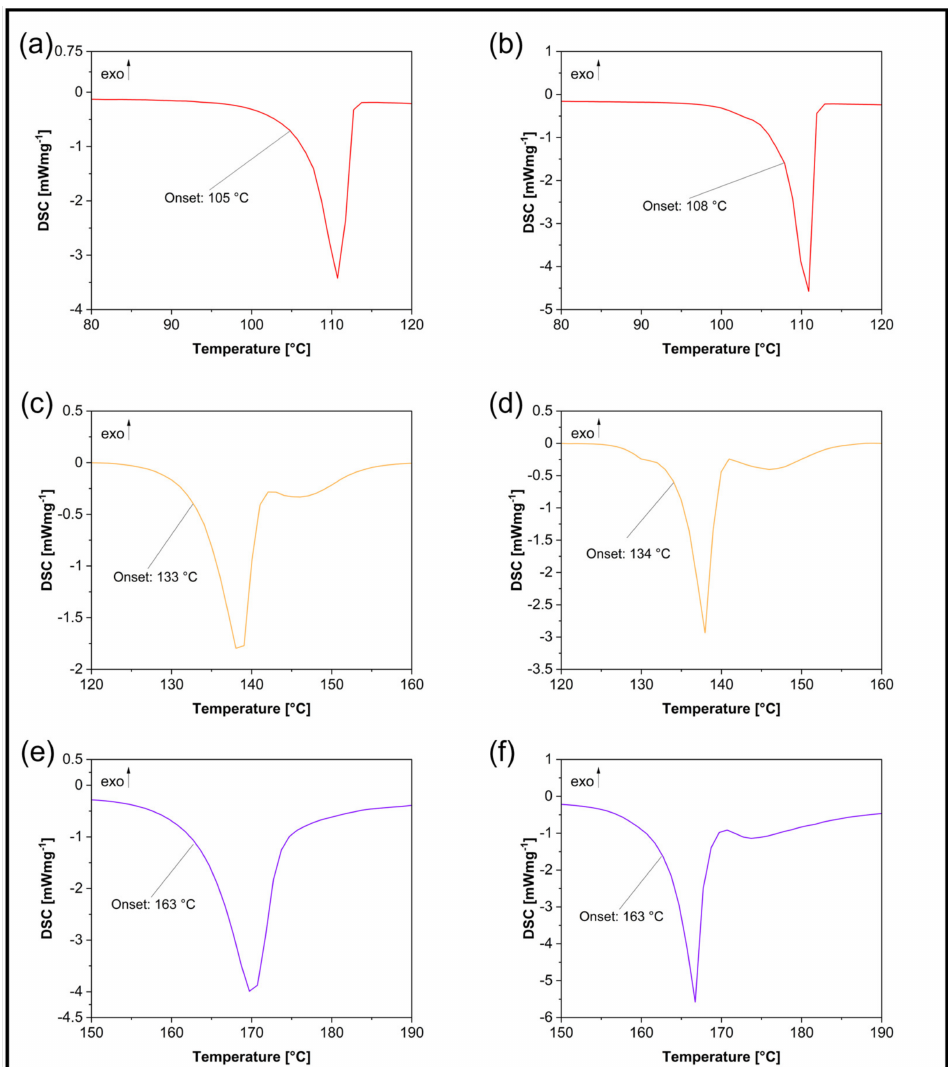
Figure 10. DSC-thermograms of MA systems showing similar thermal behavior independent of the synthetic route: 1-MA synthesized from solution ( a ) and mechanochemically ( b ), 4-MA synthesized from solution ( c ), and via grinding ( d ), 5-MA synthesized from solution ( e ), and mechanochemically ( f ). For a better visibility, only the relevant temperature range is